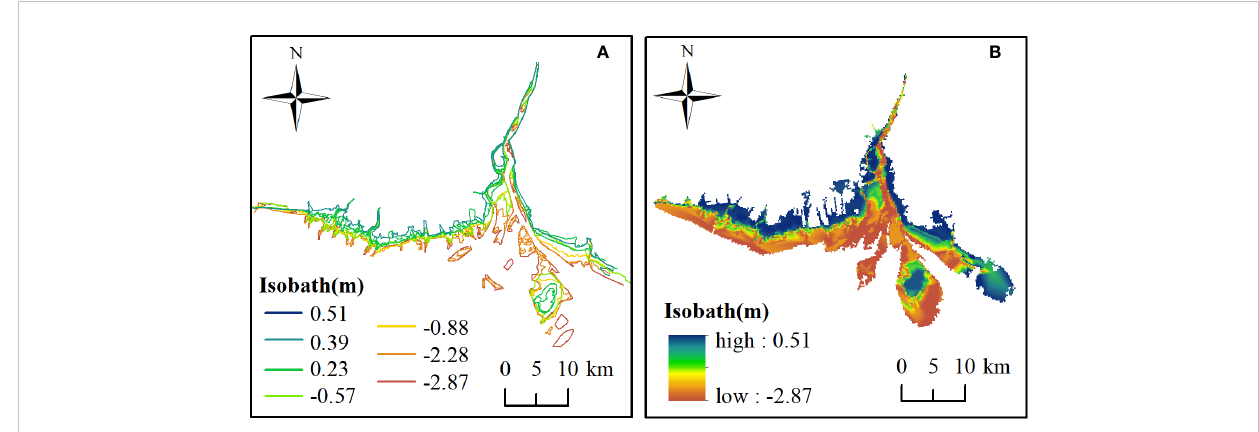
FIGURE 2 The extracted waterlines (A) and interpolated DEM (B) in 2011.